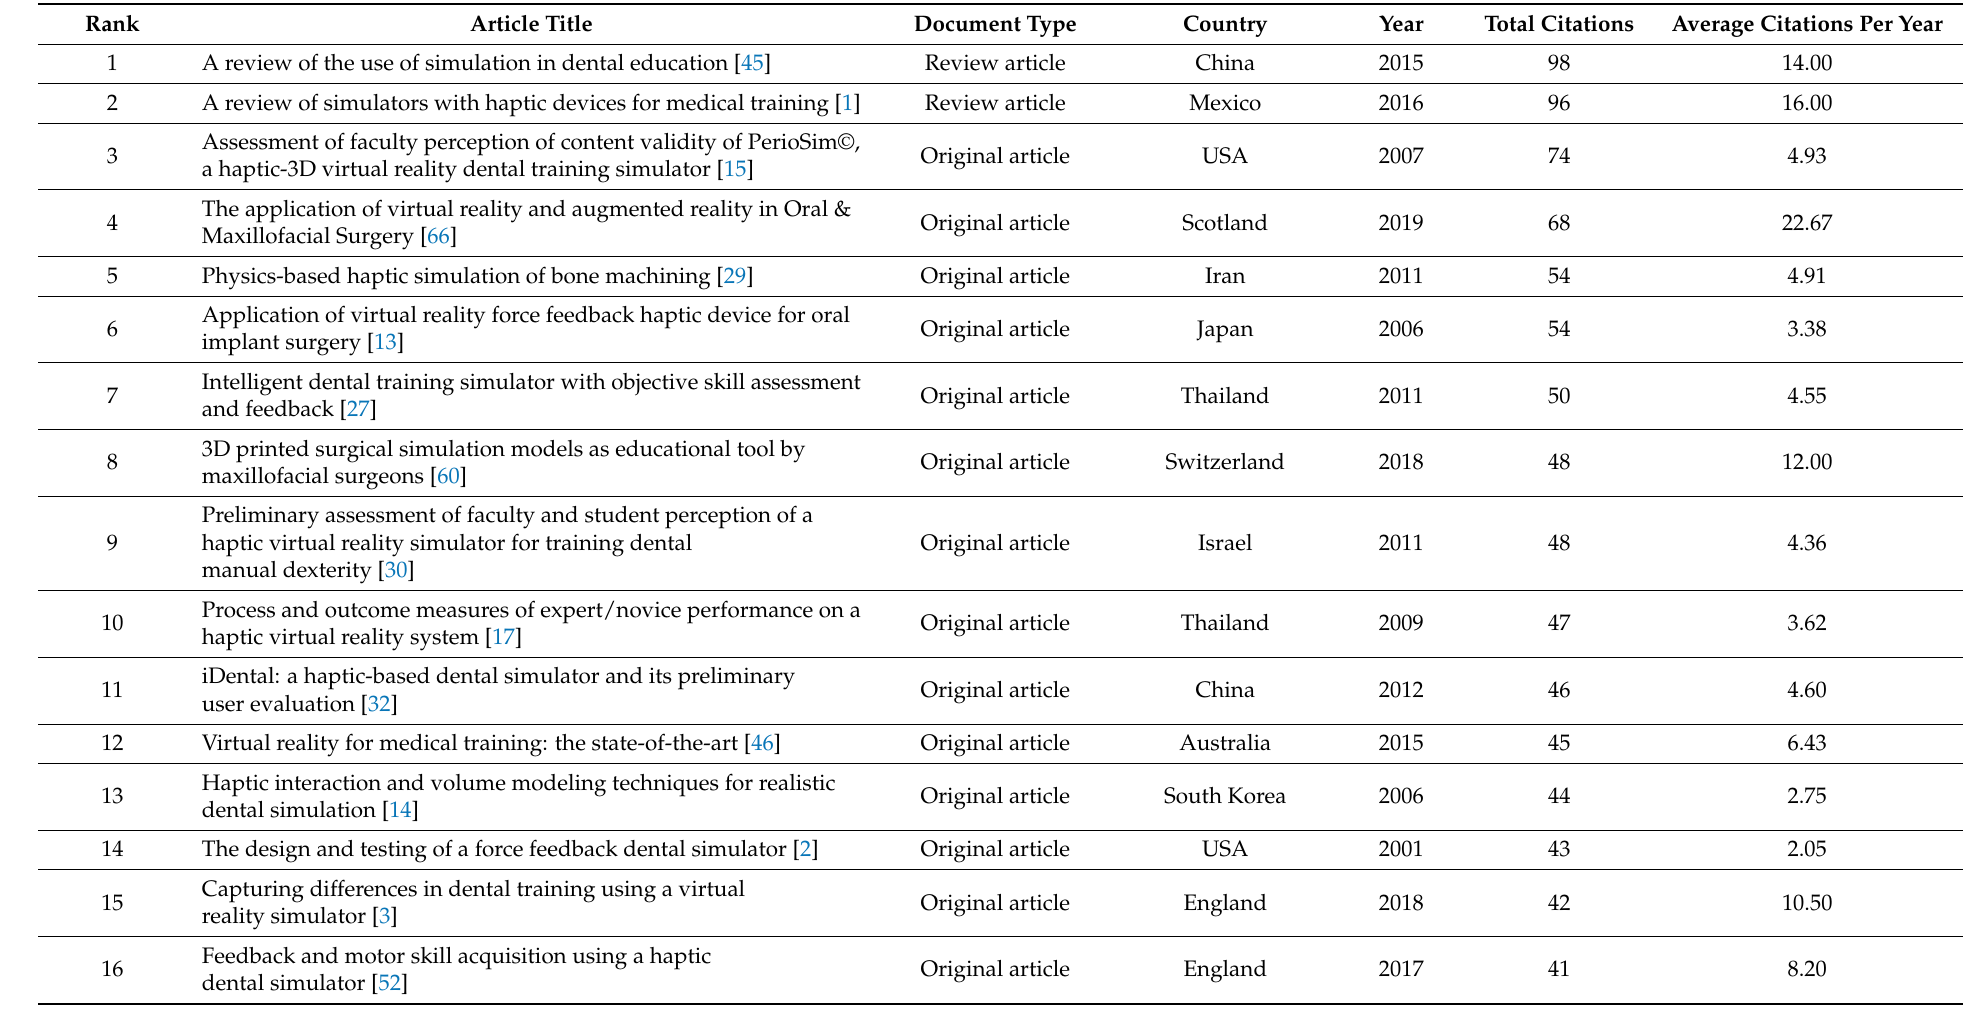
Table 2. The top 30 most-cited articles based on the total